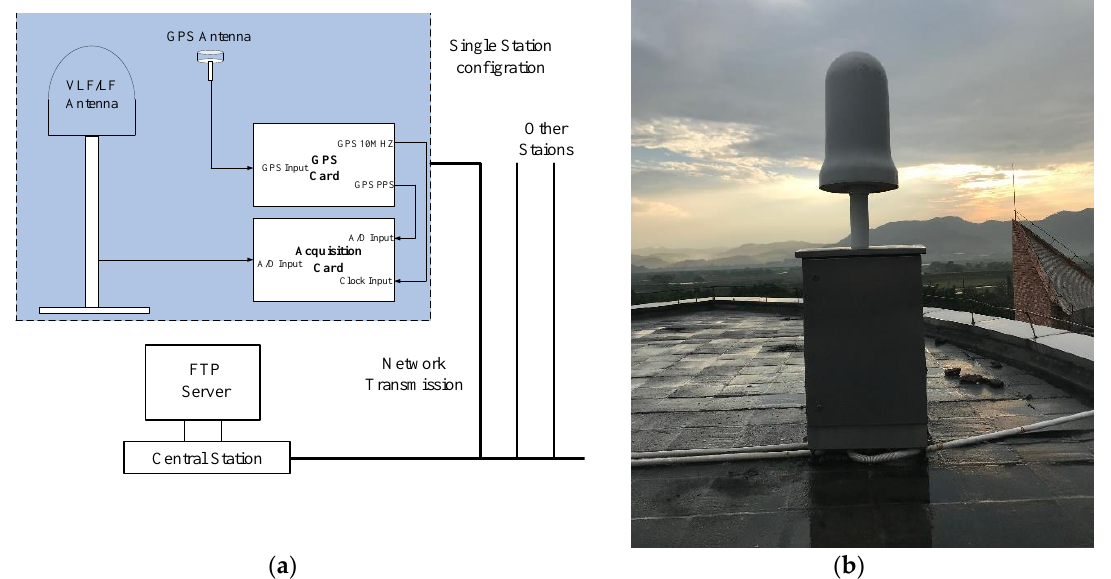
Figure 2. ( a ) The network configuration and setup. Each sub-station contains a GPS antenna, GPS card, data acquisition card, electrical field antenna and an industrial personal computer. ( b ) The installation diagram of DTZ. An elevated flat plate antenna used for measuring electric field pulses at the DTZ.